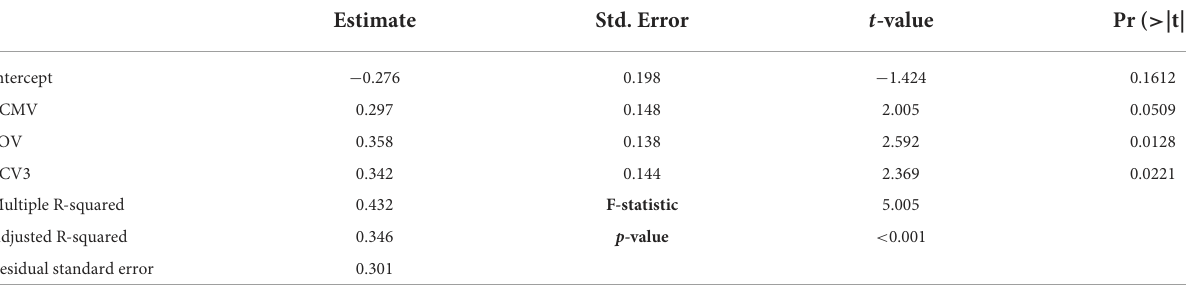
TABLE 4 Regression models. The tables show the significant regression models at a farm level (A) or individual level (B). A. Farm